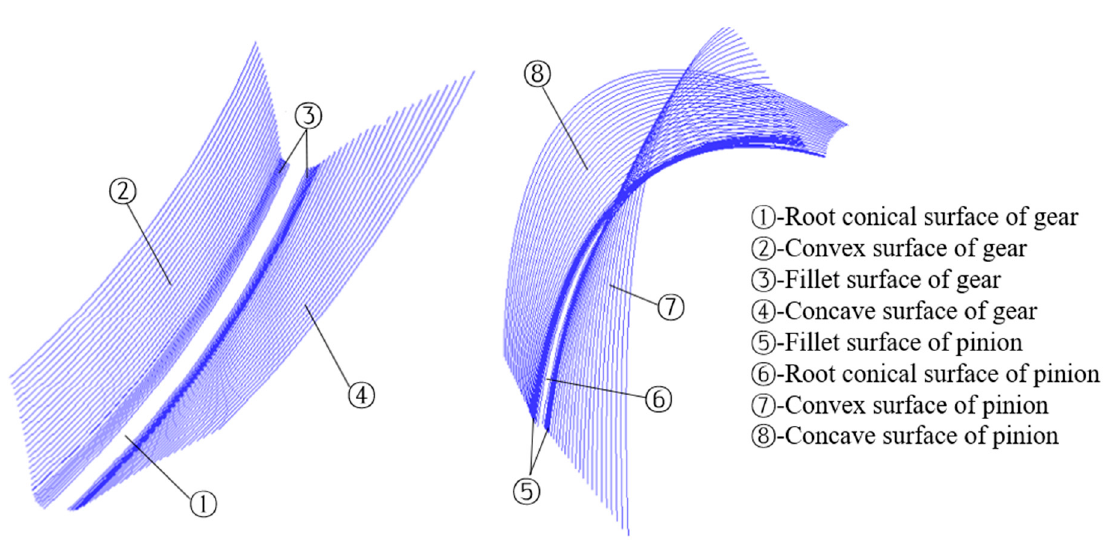
Figure 6. Spline curves of the gear and pinion.